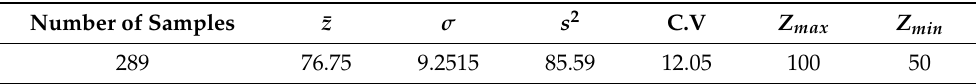
Table 1. Skewness and kurtosis of the